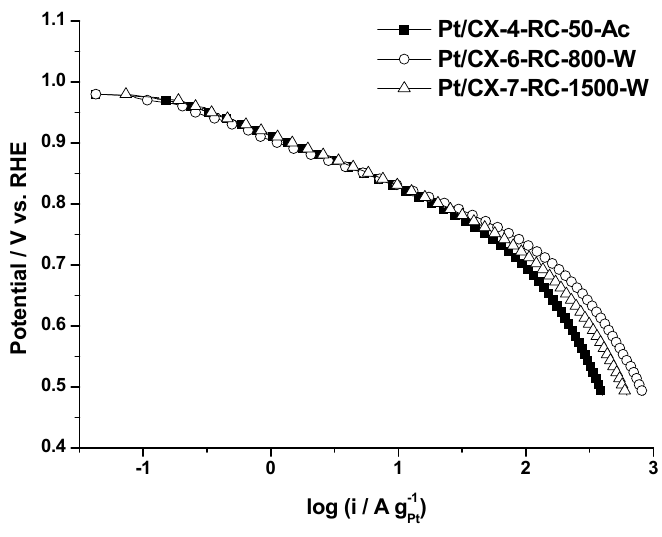
Figure 5. Polarization curves obtained in gas diffusion electrode, 0.5 M H feeding pure oxygen to the backing layer and at 25